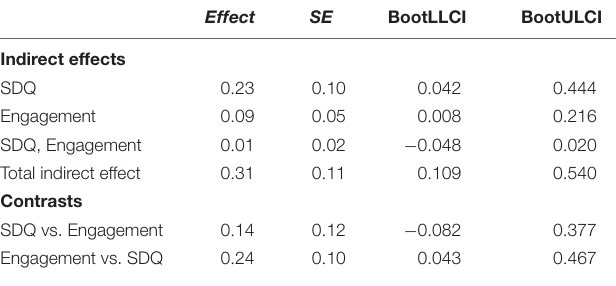
TABLE 4 | Completely standardized indirect effects and contrasts between SDQ and engagement indirect effects on the path from ASD symptoms to PSI mediated